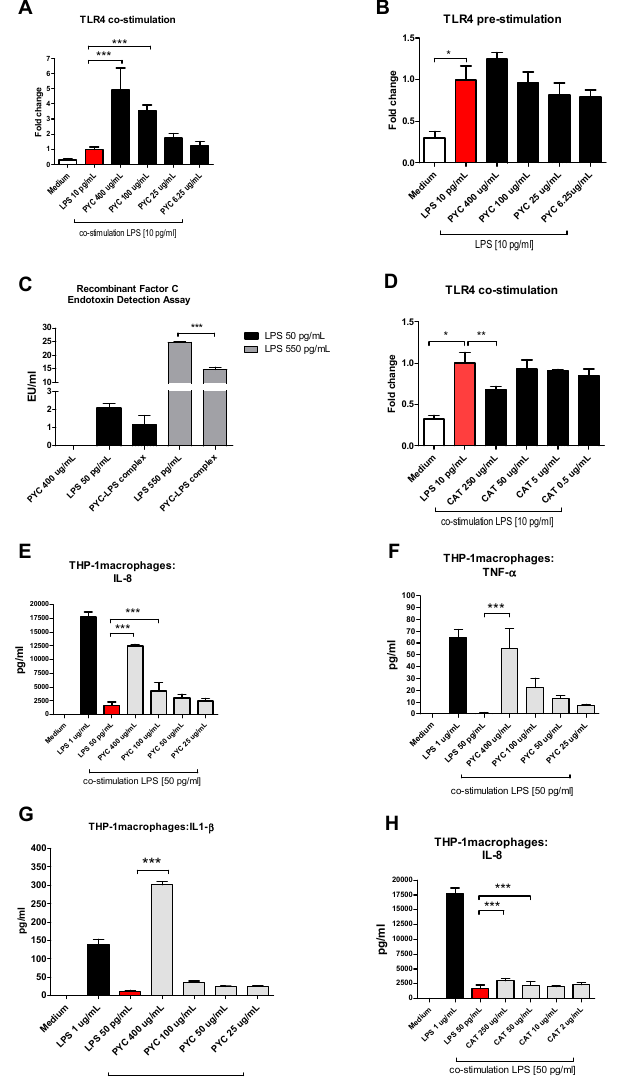
Figure 4. PYC and LPS form complexes, which boost activation of TLR4. ( A ) PYC was pre-incubated with LPS (10 ng/ml) 30 min before addition to the TLR4-expressing HEK cells, followed by 24h incubation. ( B ) TLR4-expressing HEK cells were pre-incubated with PYC, followed by washing and incubation with LPS (10 ng/ml) for 24h. ( C ) LPS concentration in pure PYC sample (400 µg/ml) and after 30 min incubation with LPS standard (50 and 550 pg/ml) expressed in LPS units EU/ml. ( D ) CAT was pre-incubated with LPS (10ng/ml) for 30 min before addition to the TLR4-expressing HEK cells for 24h. Results of A, B, and D are expressed as fold change of fluorescence intensity to the cells stimulated with 10 ng/ml LPS. Concentration of ( E ) interleukin (IL)-8, ( F ) tumor necrosis factor (TNF)- α , and ( G ) IL-1 β in supernatants of THP-1 macrophages after incubation with LPS (1 and 50 pg/ml) and with PYC-LPS complexes formed during 30 min pre-incubation of LPS (50 pg/ml) with different concentrations of PYC. (( H ) Concentration of IL-8 in supernatants of THP-1 macrophages after incubation with LPS (1 and 50 pg/ml) and with CAT-LPS complexes formed during 30 min pre-incubation of LPS (50 pg/ml) with different concentrations of CAT. All data ( n = 4 technical replicates from two independent experiments) are expressed as the mean ± SD. P-values < 0.05 are considered statistically significant, as analyzed with one-way ANOVA with Tukey post hoc comparison test (GraphPad Prism). Significant differences are indicated by asterisks: * p < 0.05; ** p < 0.01; *** p < 0.001.